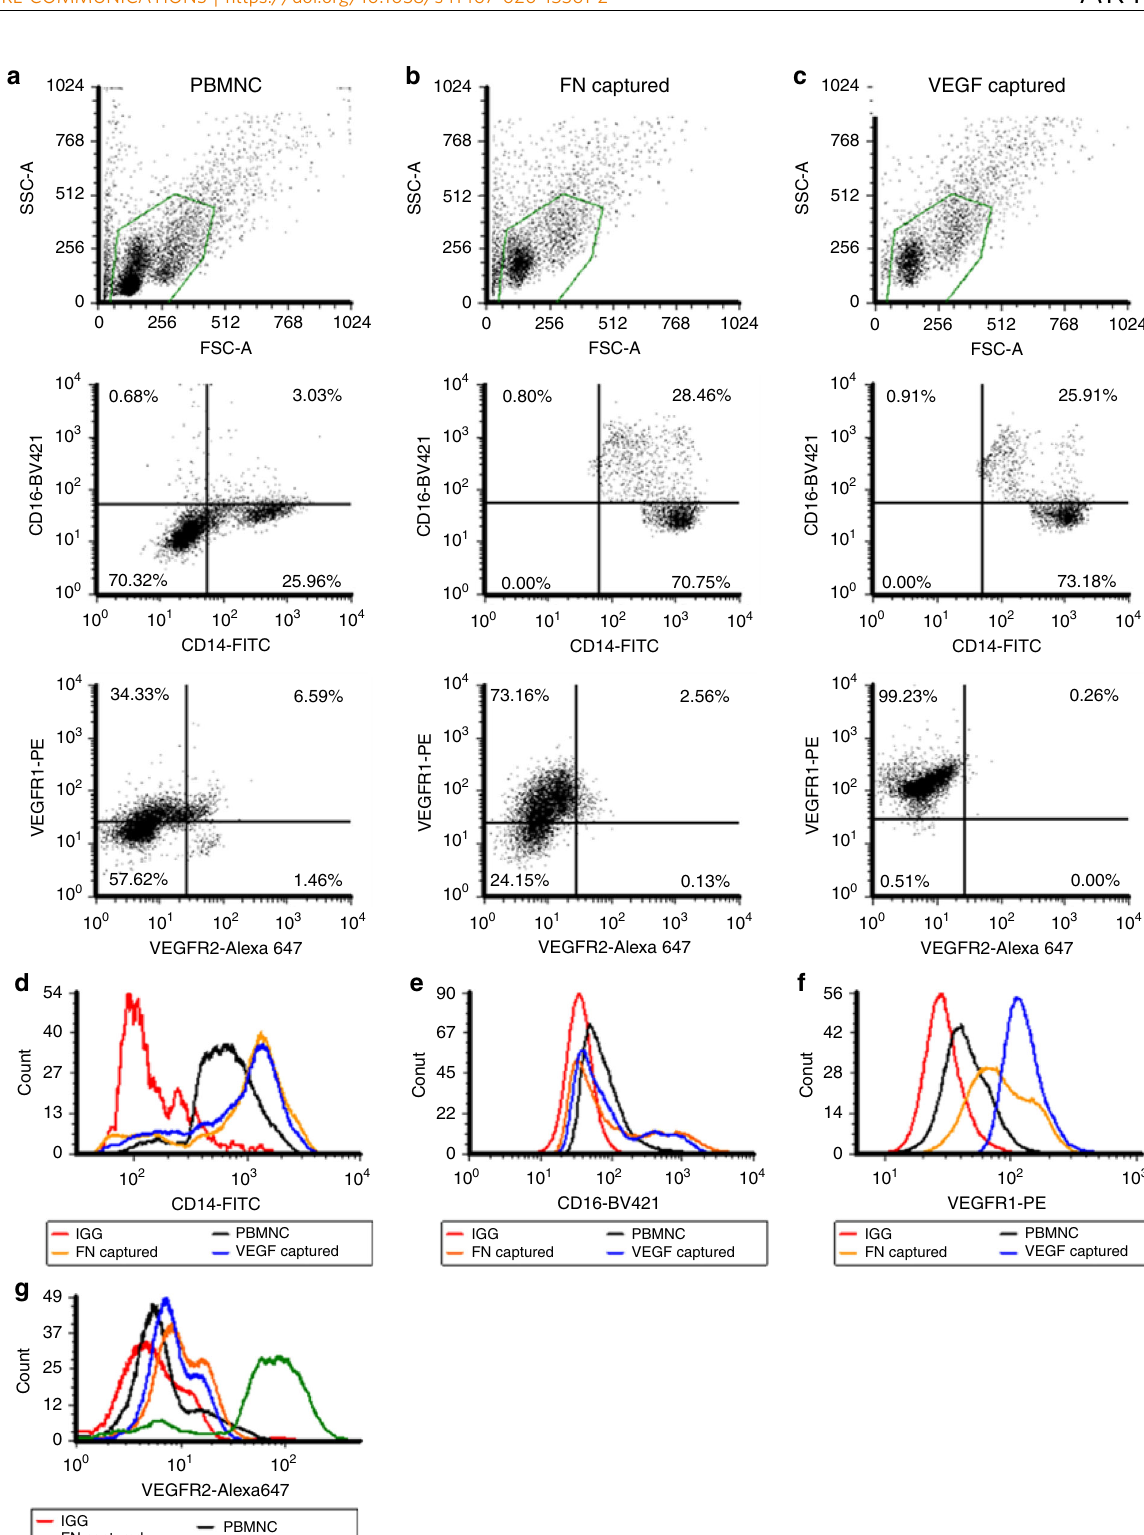
Fig. 3 Characterization of PBMNs from whole blood. Multi-color fl ow cytometry assessment of PBMNCs a isolated directly from whole blood; or b after 1 h capture on FN surface; or c after 1 h capture on iVEGF. Cells were only gated by FSC/SSC (green gate), no sub-gates were used in order to show the entire population of cells adhered to the surfaces. Flow cytometry histograms demonstrating positive signal shifts ( d – g ). HUVEC served as a positive control for